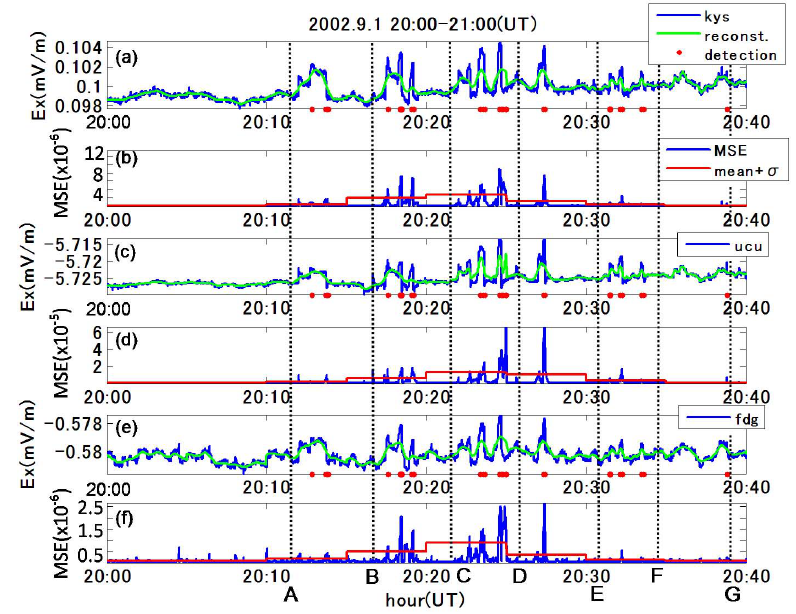
Fig. 19. An example of the DC-driven train noise detection in Ex component with multiple station data. The analyzed period is 20:00– 20:40, on 1 September 2002(UT). ( a , c and e ) The observed data and the reconstructed data using SSA decomposed components with high correlation values at KYS, UCU, and FDG, respectively. ( b , d and f ) MSE and the threshold values at KYS, UCU, and FDG, respectively.